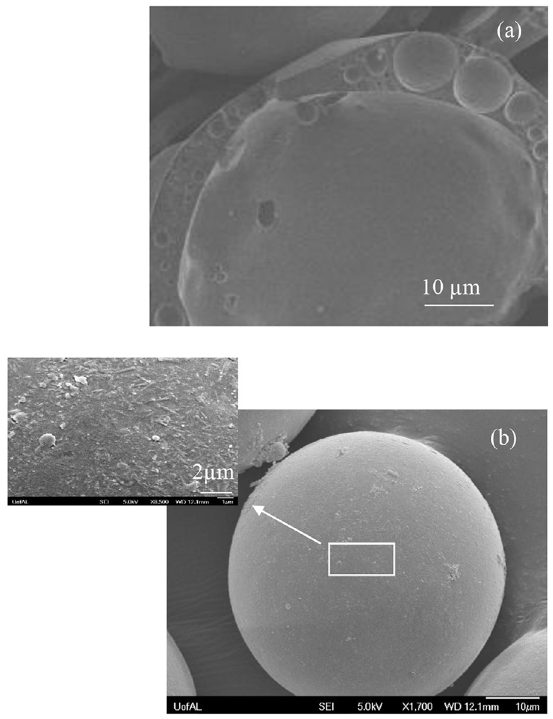
Figure 2: Structure of cenosphere shell: a) porous shell, b) solid external shell